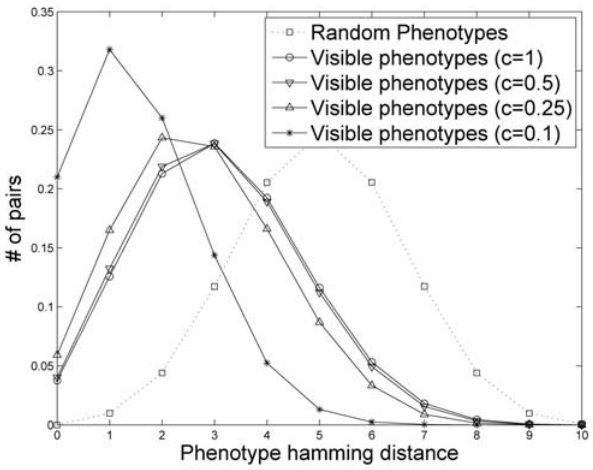
Figure 8. The distribution of pairwise phenotypic Hamming distances among randomly selected phenotypes (not pro- duced by a developmental plan) and visible phenotypes (including all occurrences of each phenotype) produced by developmental plans with varying levels of density, c . Each curve represents the average of 100 different plans. Due to computational constraints, the regulatory dimension, r , and the phenotypic dimension, k , are both set to 10.